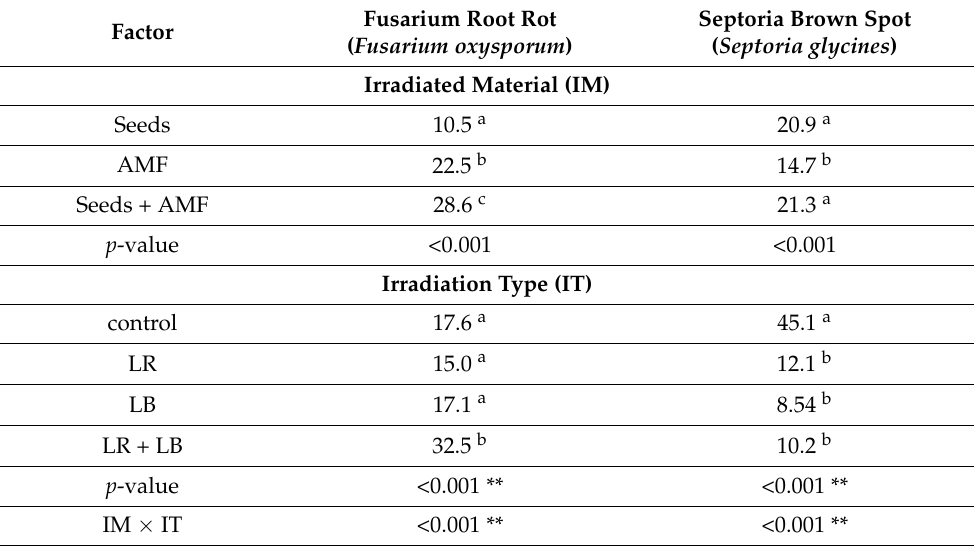
Table 3. Effect of irradiation stimulation on the diseases